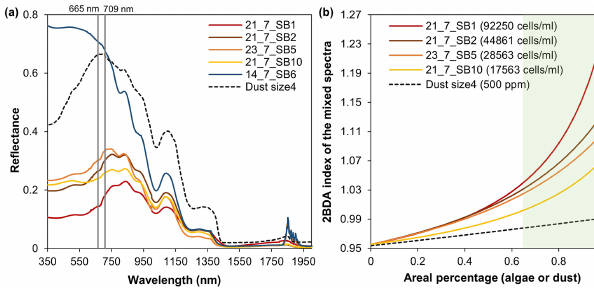
Figure B2. Spectral linear mixing experiments. (a) Field hyper- spectral measurements of four algae-abundant samples (21_7_SB1, 21_7_SB2, 23_7_SB5, and 21_7_SB10) and one bare ice sample (zero algal abundance, 14_7_SB6) from Cook et al. (2020), and the SNICAR-simulated spectra for the dust scenario (size 4 at concen- tration of 500ppm). (b) The 2BDA index calculated from the lin- early mixed spectra with varying areal percentage at subpixel scale for algae (different algal abundances) and dust scenarios.